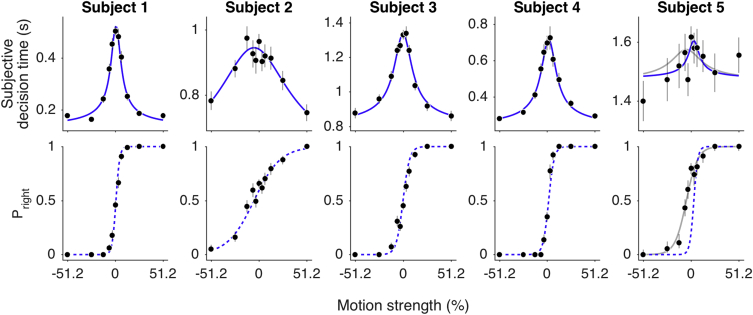
Subjective Decision Times Reflect Termination of a Decision ProcessData are from five participants tested on a controlled-duration task for the trials in which the motion display lasted 800 ms. Subjective decision times (top) and proportion of rightward choices (bottom) are plotted as a function of motion strength (negative and positive values indicate leftward and rightward direction, respectively). Blue solid lines are drift-diffusion fits to the tSD data, and blue dashed lines are predictions using the parameters of the tSD fits (parameters in Table 1). For subject 5, the gray lines are the joint fits to the tSD and choice. Points are means ± SEM.